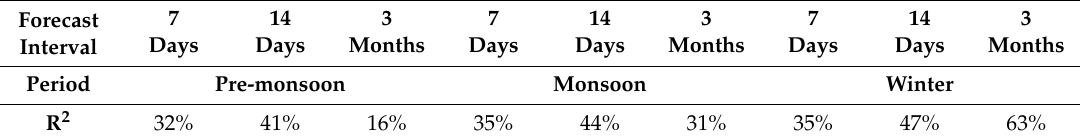
Table 2. R 2 for 7-, 14-days and 3 months of meteoblue forecast with the observations for Khulna station. Results of R 2 are expressed in % to indicate the variability explained by the forecasts.